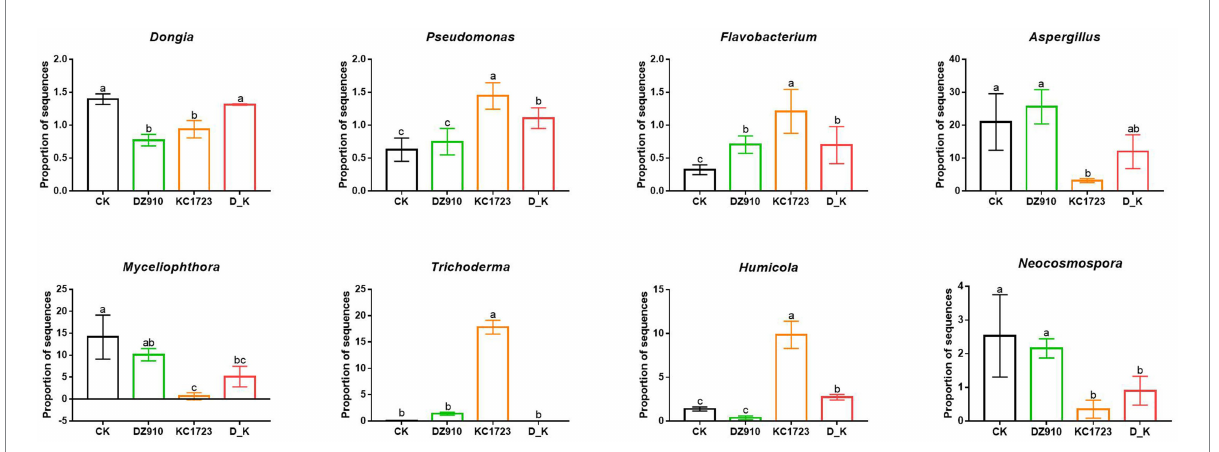
FIGURE 3 Effects of different microbial agents on several key microorganisms. The letters indicate significant differences among the different treatments (analysis of variance [ANOVA]: Duncan test; p < 0.05).